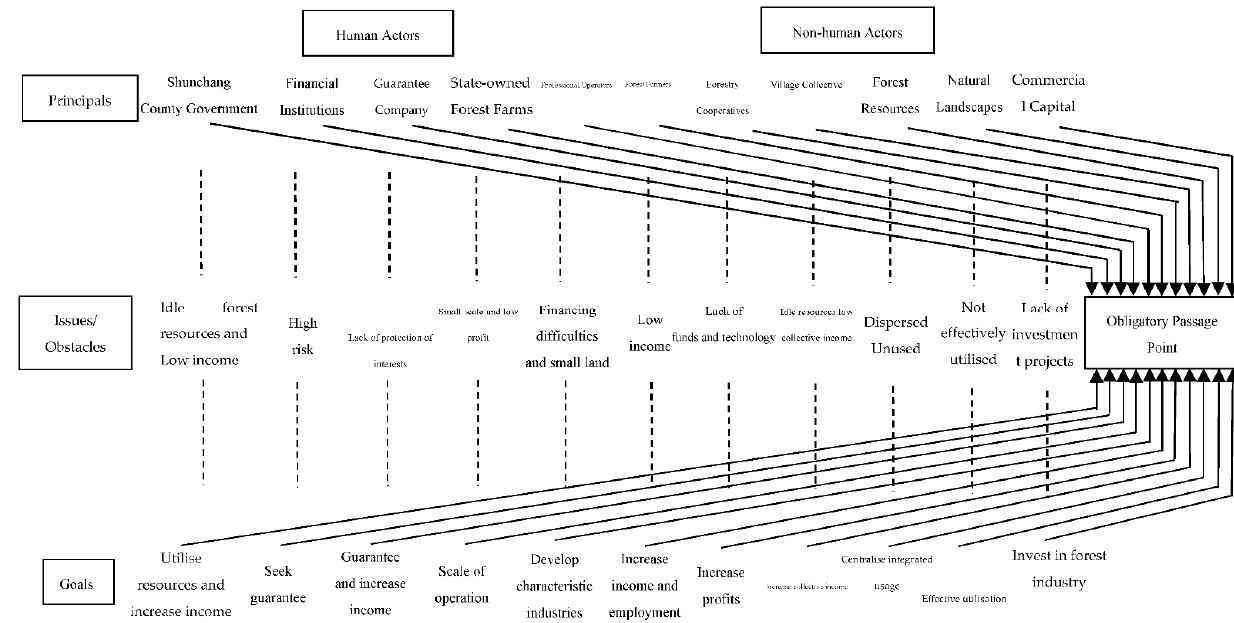
Figure 3. The interest requirements and objectives of the various actors of the FEB.